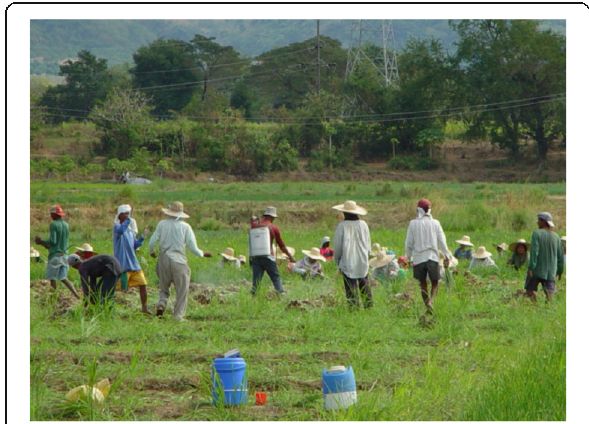
Fig. 3 Manual application of pesticides (center) with potential exposure of workers during manual crop maintenance operations in Southeast Asia (Source: S.